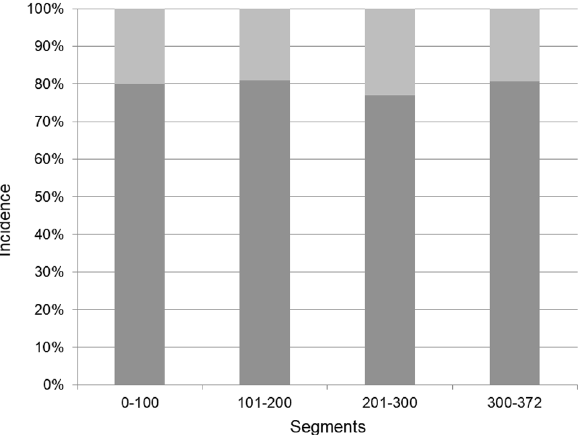
Figure 1. The incidence of intraoperative endplate injury at every consecutive 100 segments shows no significant difference.